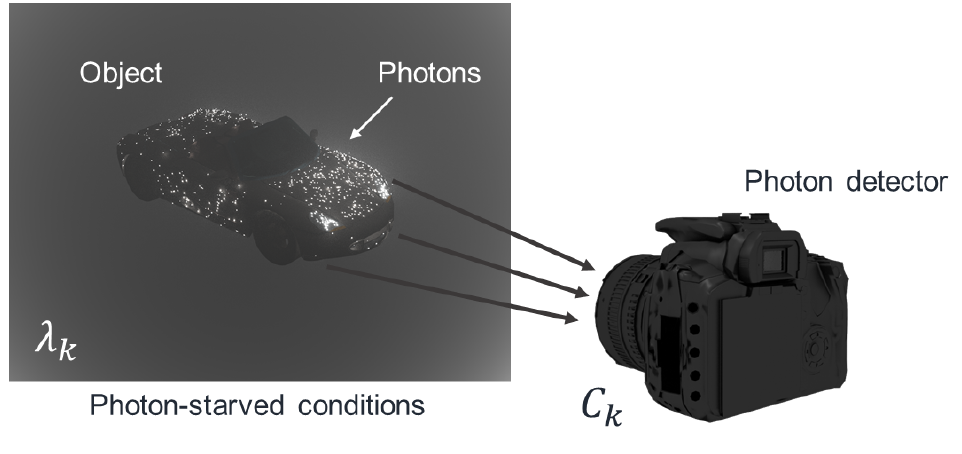
Figure 3. Physical photon counting